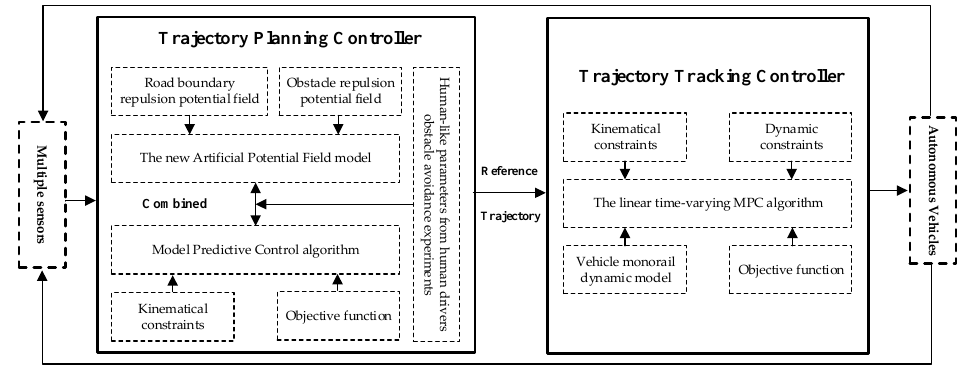
Figure 1. Human-like obstacle avoidance system framework for AVs.